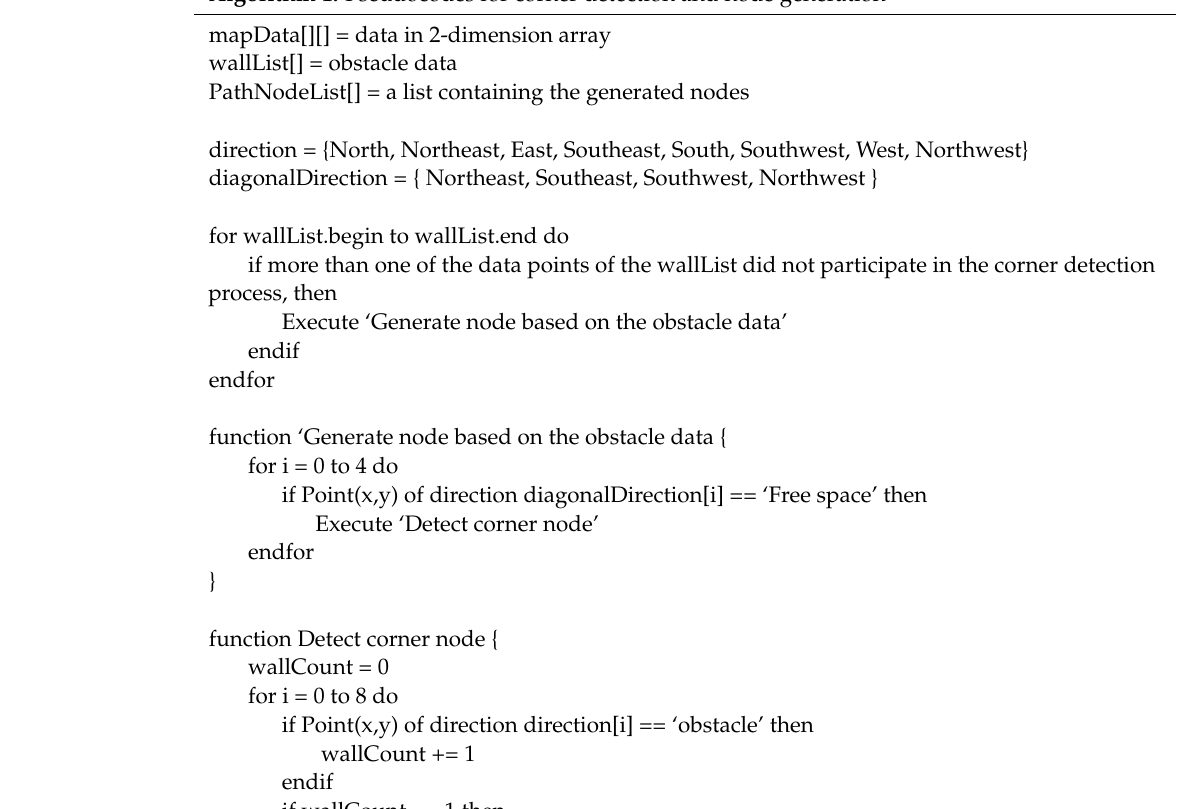
Algorithm 1: Pseudocodes for corner detection and node generation